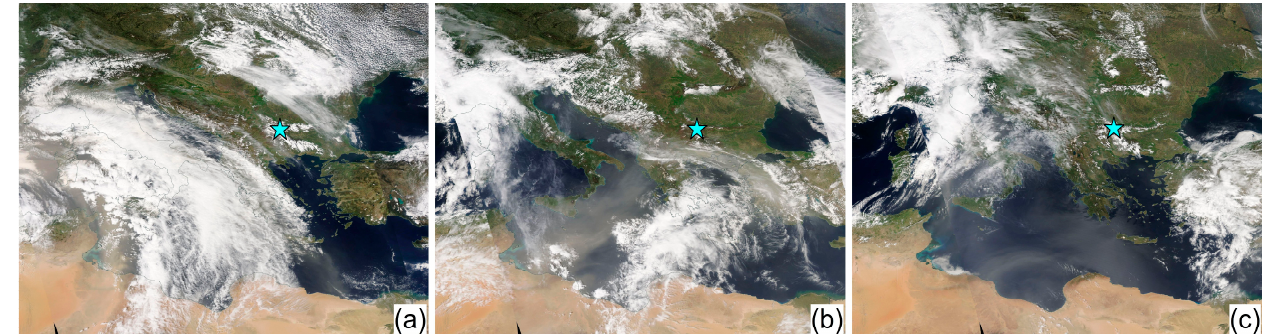
Figure 2. MODIS-Aqua true-color images of the dust-cloud plume spread for ( a ) 22 April 2019, ( b ) 24 April 2019, and ( c ) 26 April 2019. The blue star indicates the position of Sofia station. The images are downloaded from the NASA Worldview website (https://worldview.earthdata.nasa.gov/, accessed on 17 February 2022) by using the NASA Worldview Snapshots application.